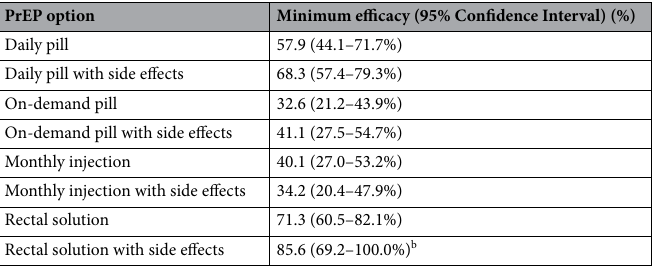
Table 3. Minimum efficacy for PrEP options to be preferred over usual care a . a Usual care was assumed to have an efficacy of 1%. b Upper 95% confidence limit truncated at 100%.